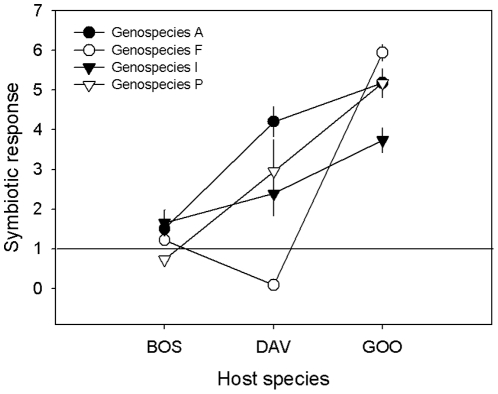
The symbiotic response of four genera of host plants to a common subset of rhizobial phylotypes (i.e. those where each host was represented by one or more of its own strains).The solid line at 1 on the y-axis indicates the level where the host did not gain or lose anything from the rhizobial interaction relative to the N− control treatment. Error bars are based on standard errors of means (if not visible, they are smaller than the symbols). Host species abbreviations are as in Fig. 1.